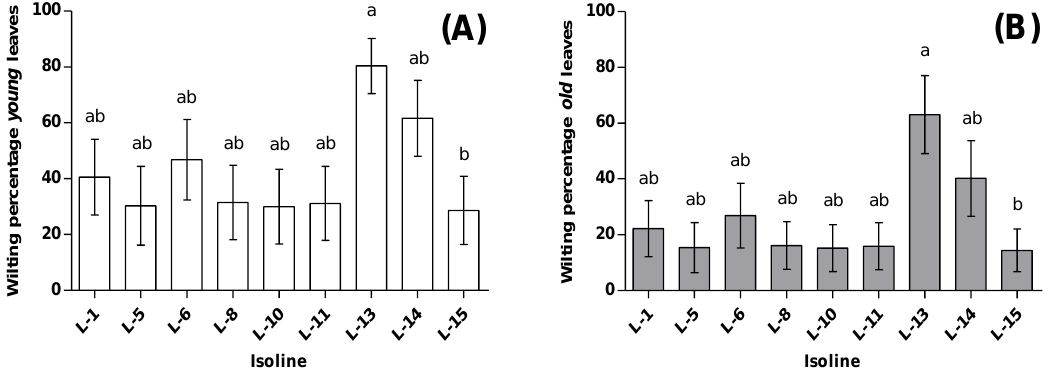
Figure 2. Average wilting percentages inflicted by N. tenuis on tomato plants. ( A ) Average wilting percentage in ‘young’ leaves, ( B ) Average wilting percentage in ‘old’ leaves. Bars sharing letters are not significantly different; error bars represent SE.